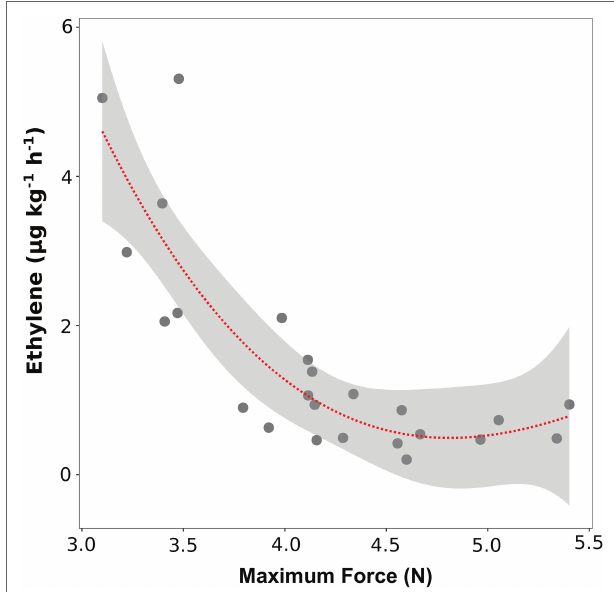
FIGURE 4 | Correlation plot and polynomial regression model between the ethylene production and the textural value of maximal force of 24 blueberry cultivars assessed after 4 weeks of storage. Ethylene measurement was assessed in four replicates on intact berries by using an PTR/SRI-ToF-MS set in O 2+ mode. Texture analysis was assessed on 10 berries by using a texture